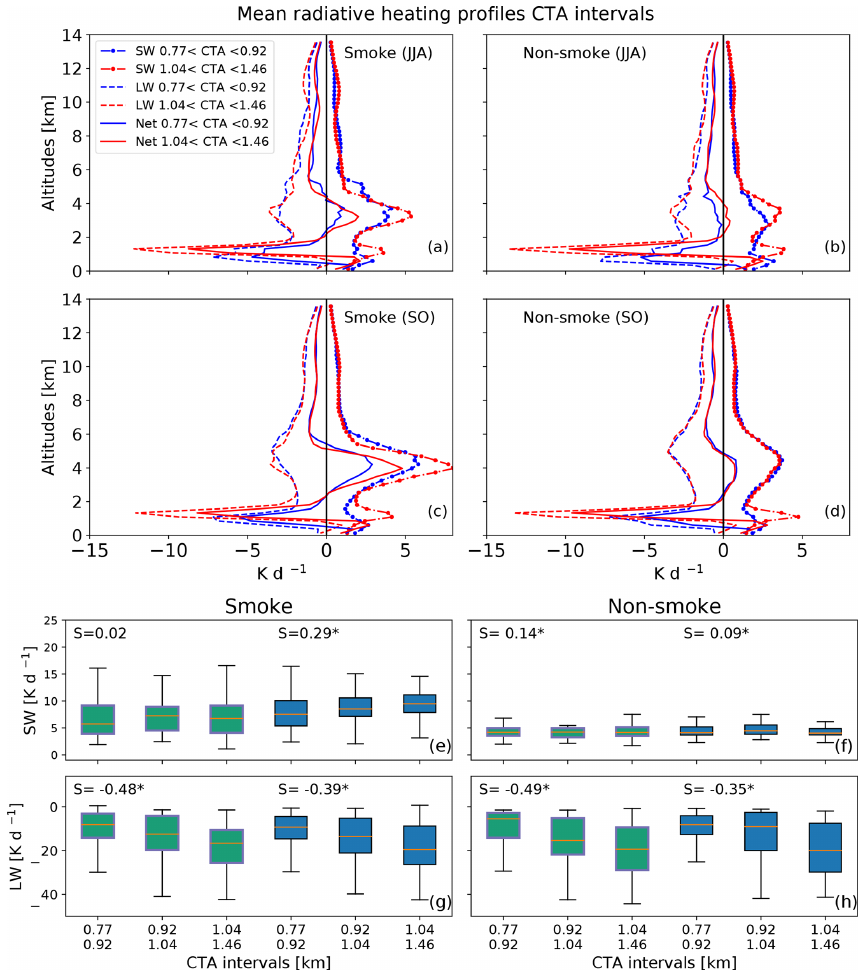
Figure A6. (a–d) Mean shortwave (SW), longwave (LW), and net (Net) radiative heating profiles for smoke and non-smoke cases with high and low RH June–July–August (JJA) and September–October (SO) of the period 2007–2010. (e–h) Box plots of SW heating in the aerosol layer (e, f) and LW cooling at cloud top (g, h) for three CTA intervals. Panels (e, g) and (f, h) correspond to the smoke and non-smoke cases, respectively. Green boxes correspond to JJA and blue boxes to SO. For each case and period the Spearman correlation coefficient ( S ) between the full range of RH values and the SW (or LW) fluxes appears on top. Significant correlations (with p value < 0 . 05) are marked with a star ( ∗